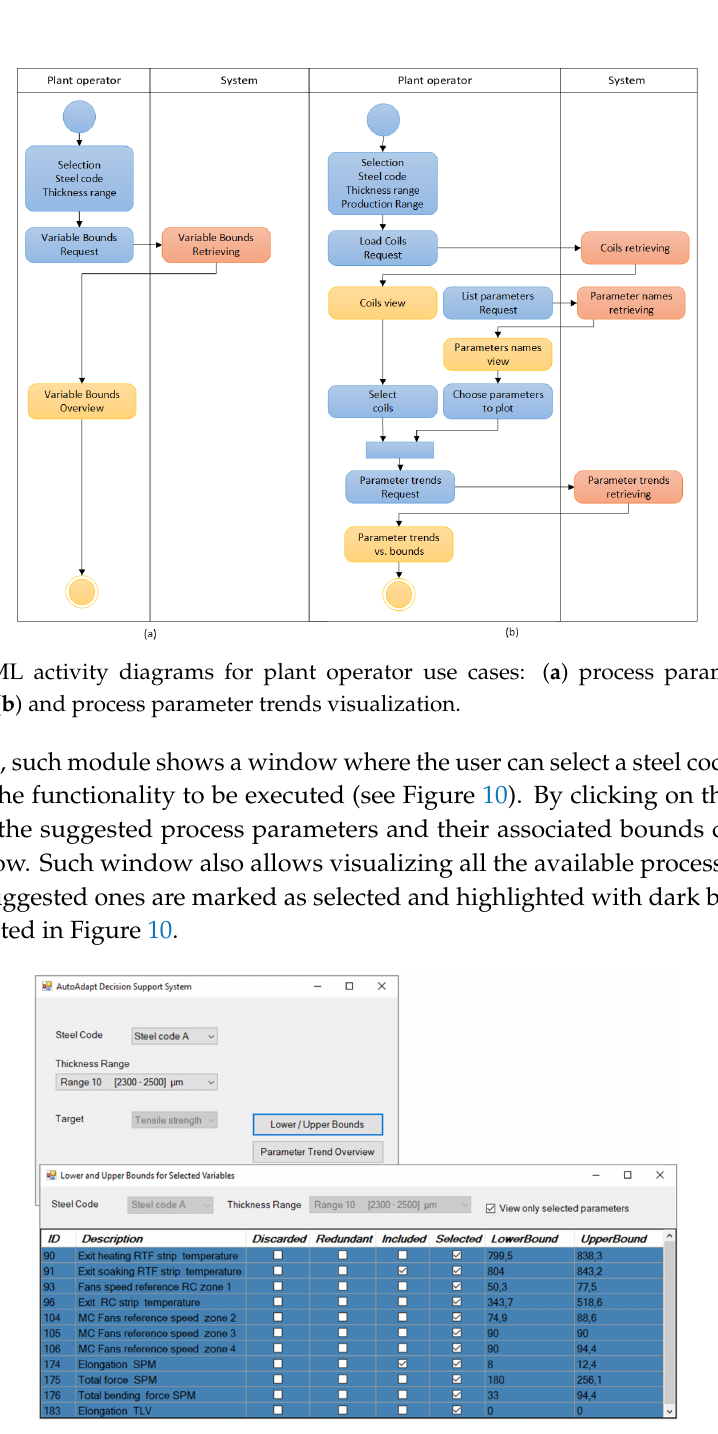
Figure 10. Use of the system to display fixed bounds for suggested parameters.